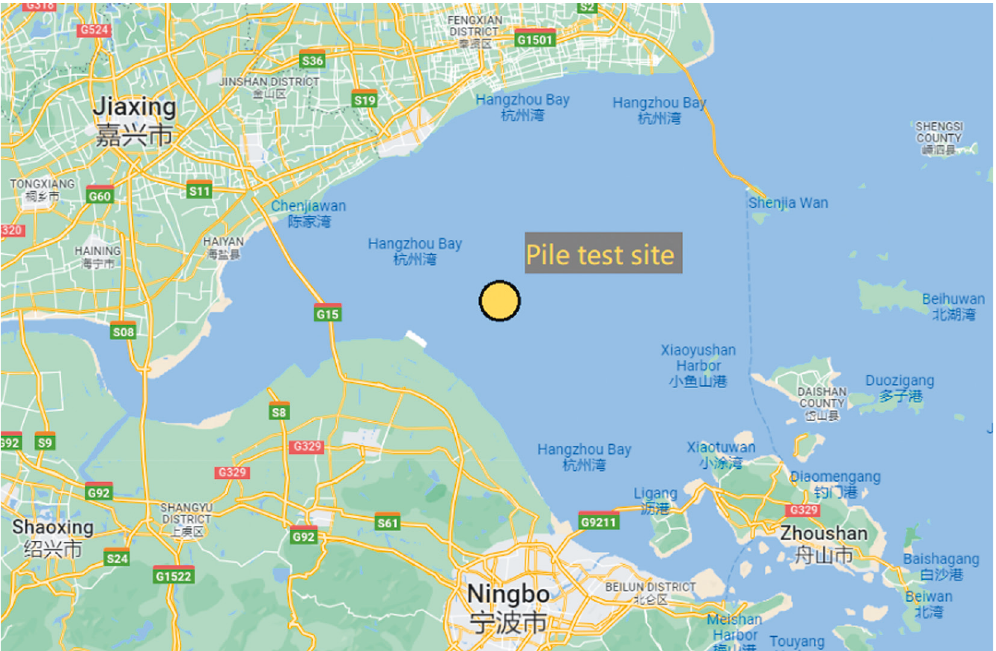
Figure 7: Pile test site location.